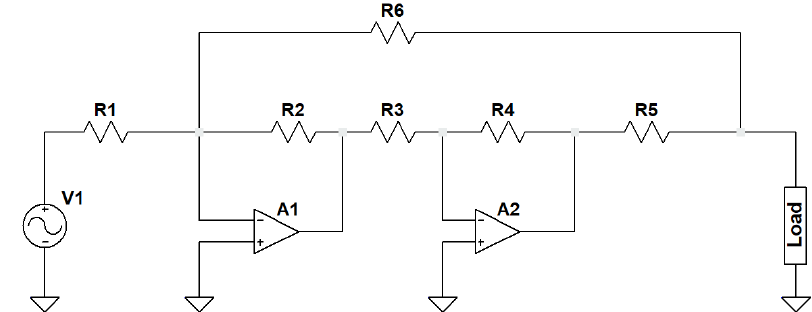
Figure 5. Tietze cascade VCCS structure.